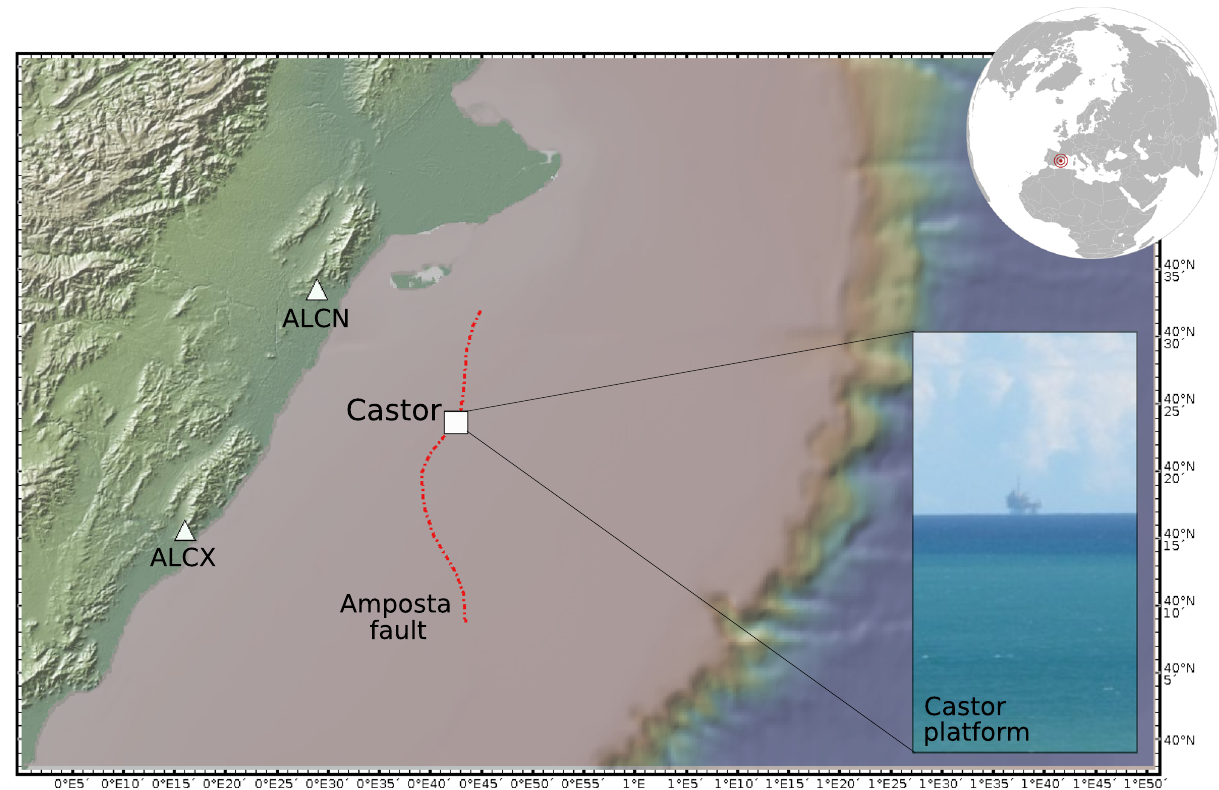
Fig. 1 Overview map of the study region offshore Spain. The map shows the location of the Castor platform (white square), closest seismic stations ALCN and ALCX (white triangles), and the approximate trace of the Amposta fault (red dotted lines) 47,48 . The upper right inset shows the geographical location of the study area, the lower right inset a photo of the Castor platform (courtesy Álvaro González). The map has been plotted with GeoMapApp (www.geomapapp.org), using the Global Multi-Resolution Topography (GMRT) 70 and regional bathymetry after the EMODNET 500 m